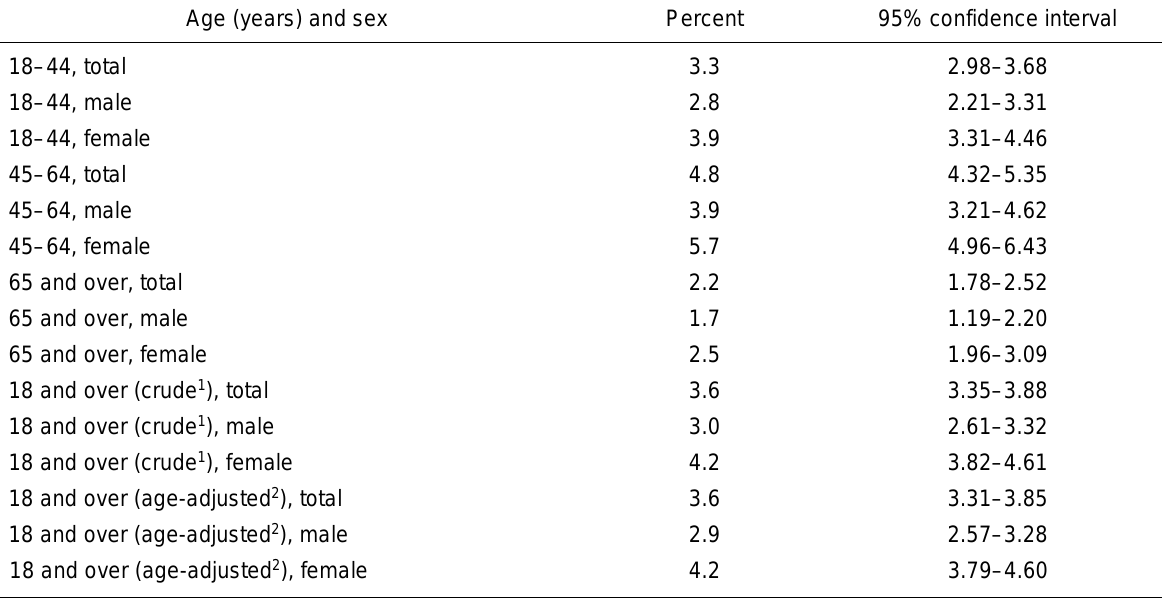
Data table for Figure 13.2. Percentage of adults aged 18 and over who experienced serious psychological distress during the past 30 days, by age